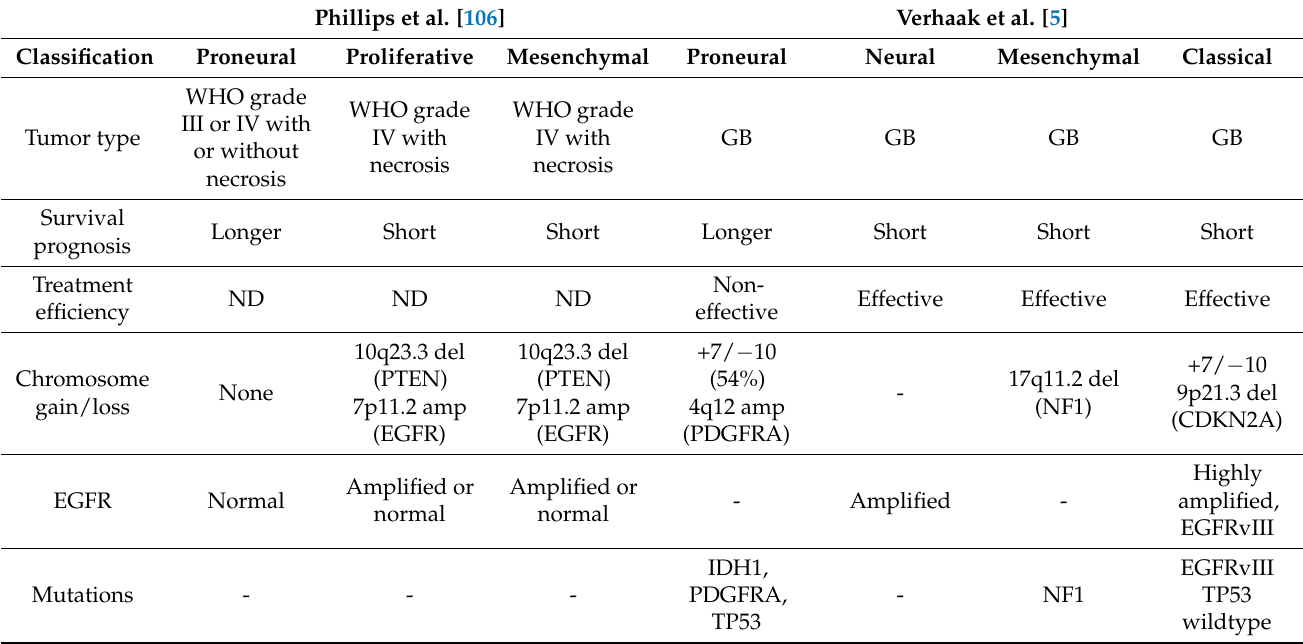
Table 1. Molecular classifications of GB